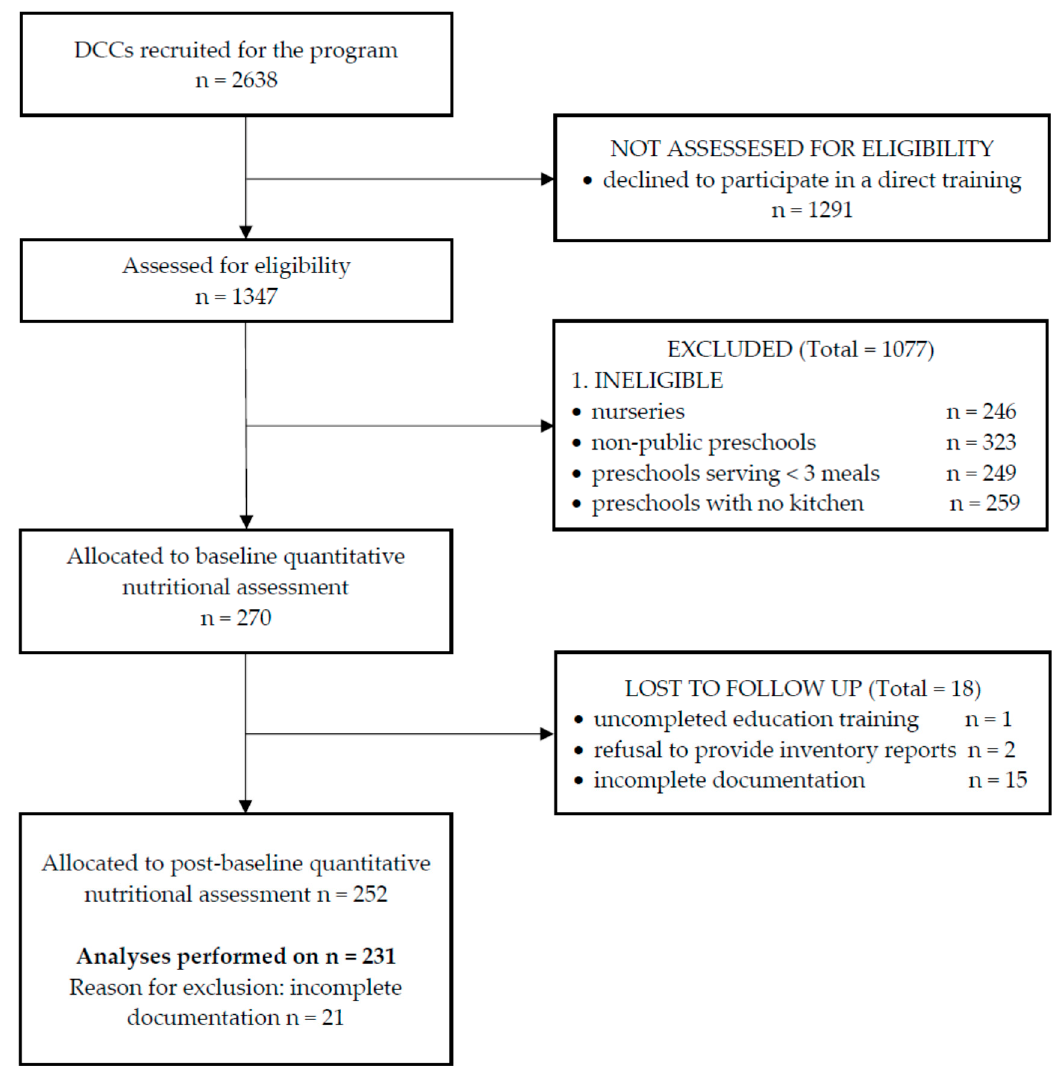
Figure 1. The sampling scheme of the present study.